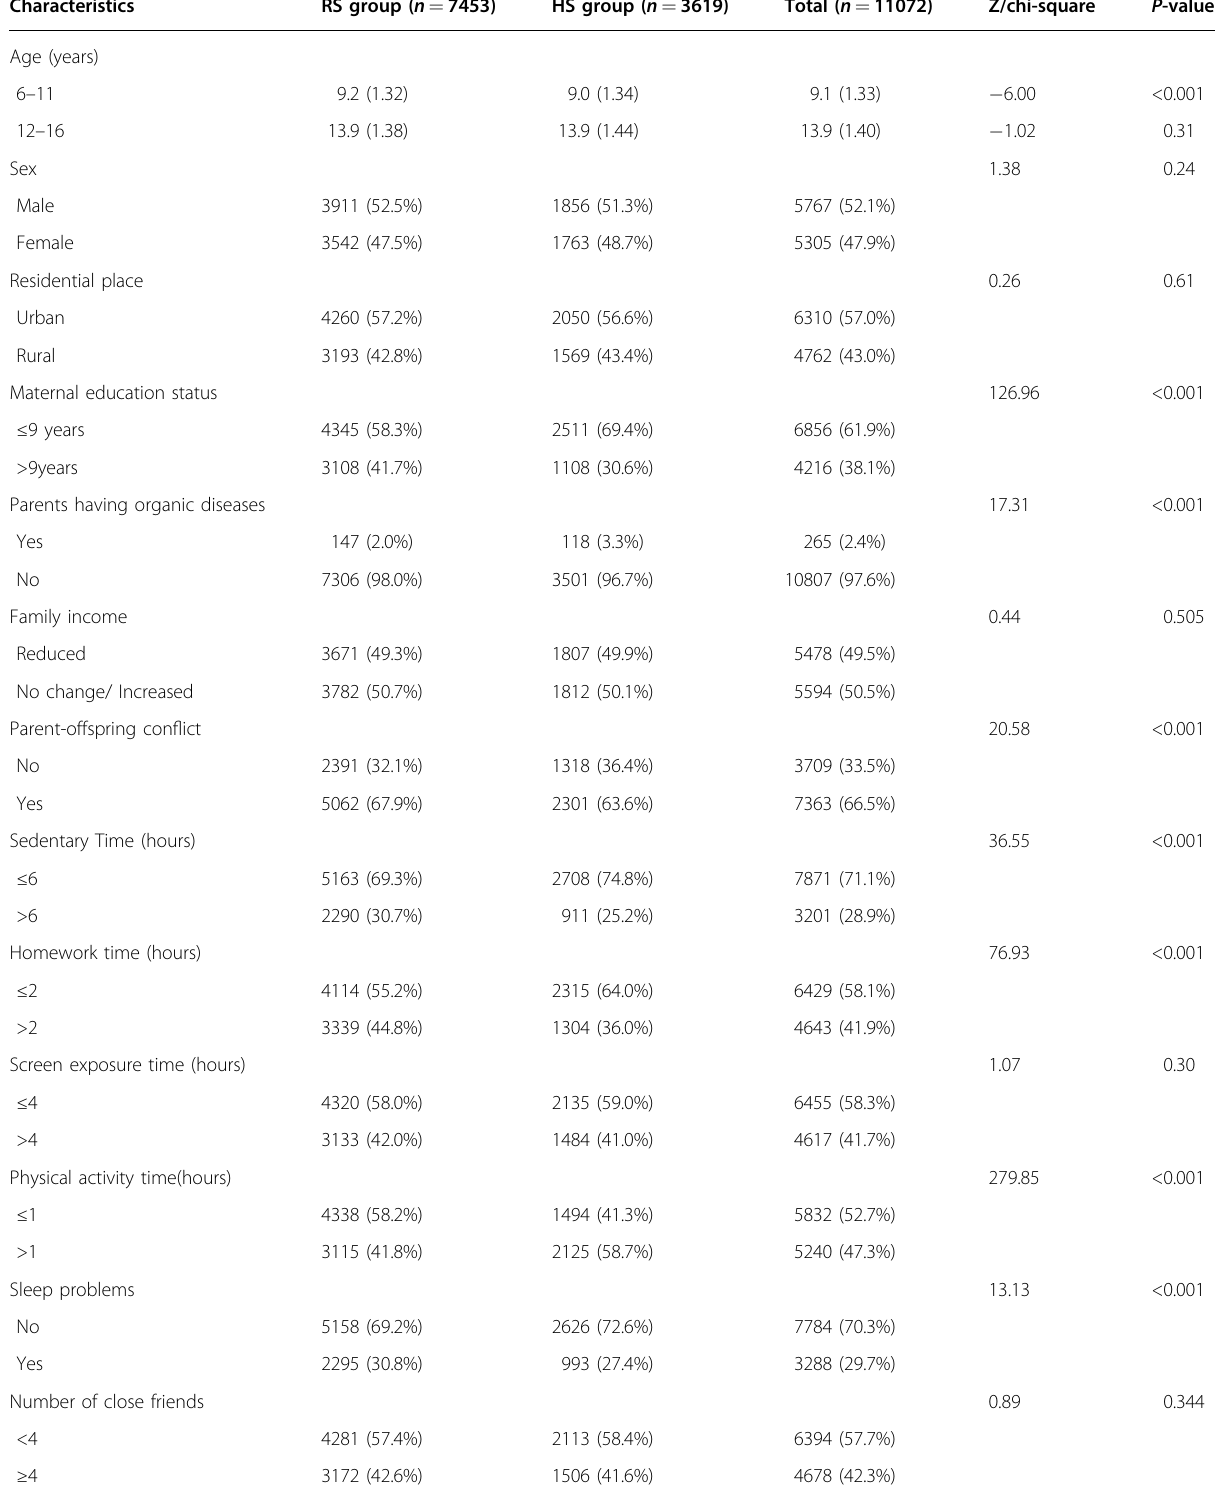
Table 1 Demographic and psychosocial characteristic of RS group and HS group during